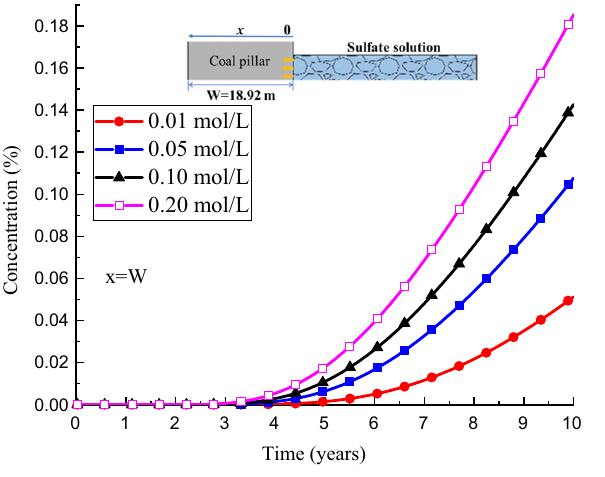
Fig. 12 Service life for coal dam affected by the sulfate in mine